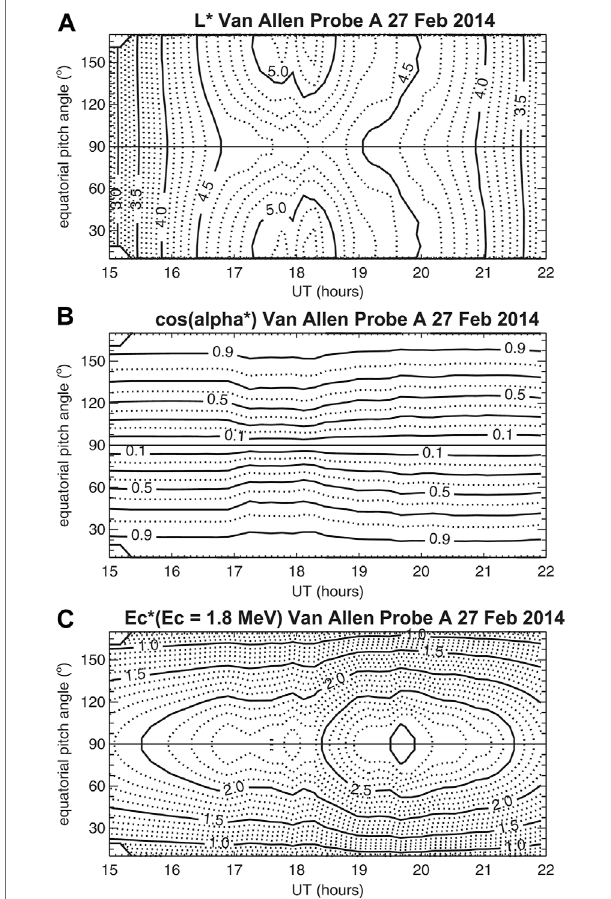
FIGURE 2 | The adiabatic coordinates ( L p , cos ( α p ) , E p c ) associated with a 1.8 MeV electron population measured by Van Allen probes A on the dayside during the 27 February 2014 event, as a function of the time of the measurement and for different equatorial pitch angles, α . From (Roederer and Lejosne,